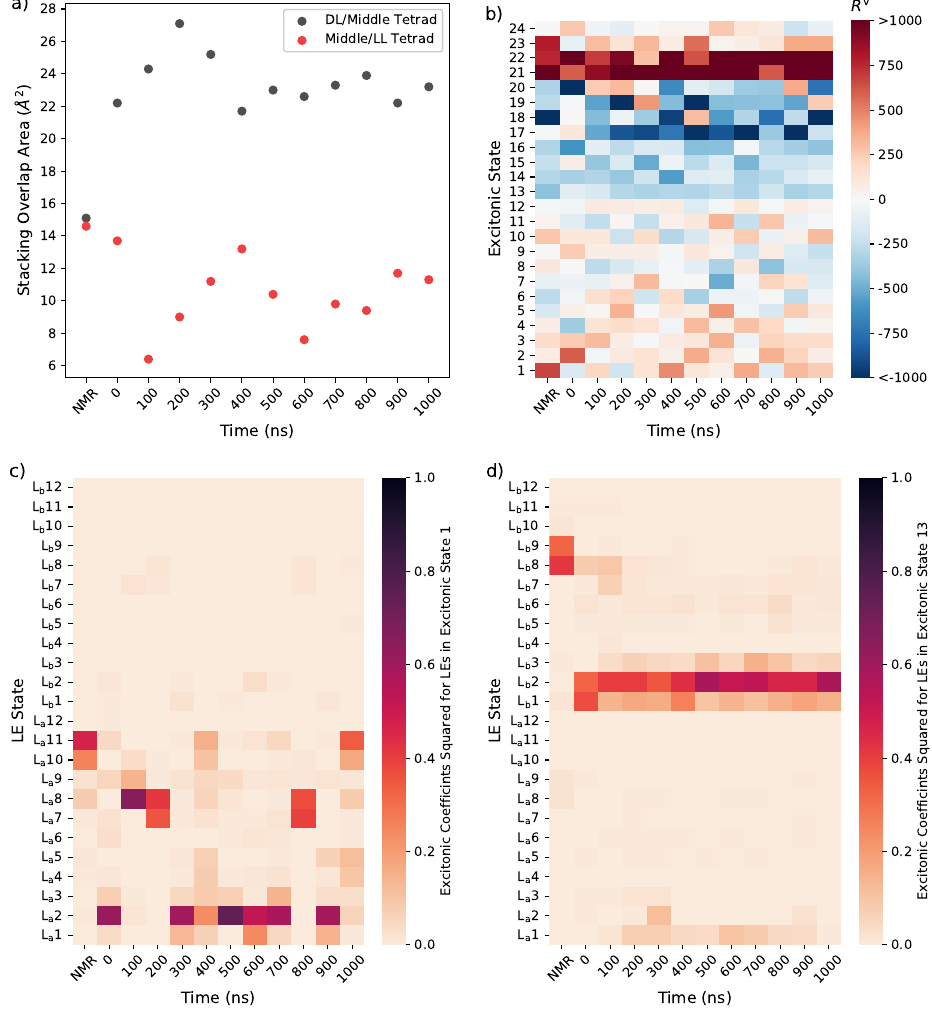
Figure 7. ( a ) Total overlap area between immediately stacked bases in adjacent tetrads, ( b ) rotational strengths of each excitonic state for each calculation of Figure 6 ( c ) coefficients of the L a /L b states of the different G’s for excitonic state 1 ( d ) coefficients of the L a /L b states of the different G’s for excitonic state